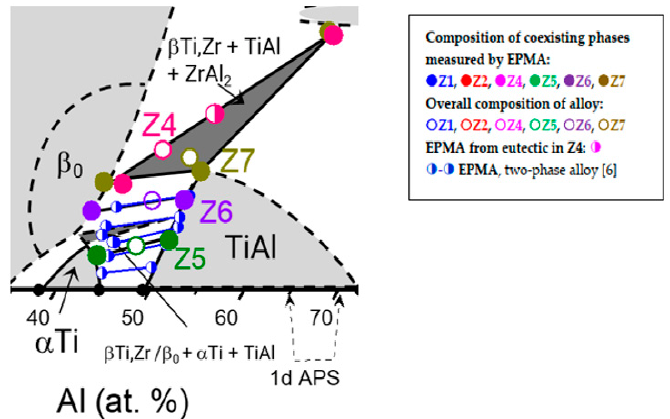
Figure 11. Enlarged section of the Ti—Al—Zr partial isothermal section at 1300 °C (Figure 9) with added EPMA data by [6].